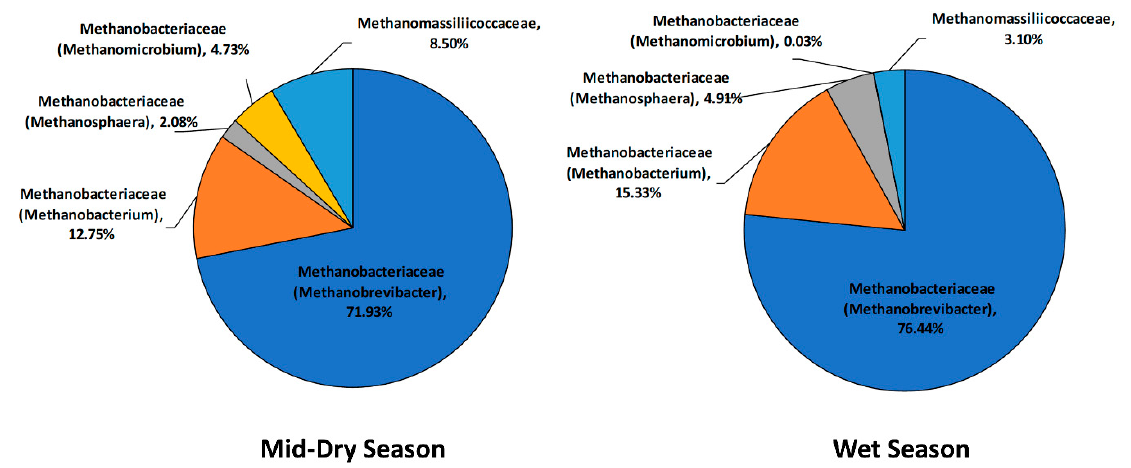
Figure 3. Taxonomic composition of the rumen archaea community at family and genus level for the mid-dry and wet seasons in un-supplemented animals.